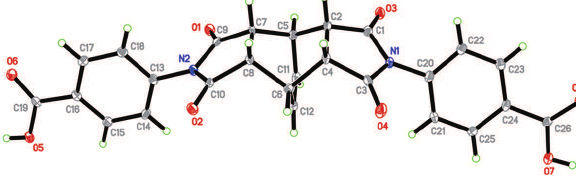
Table 1: Data collection and handling.